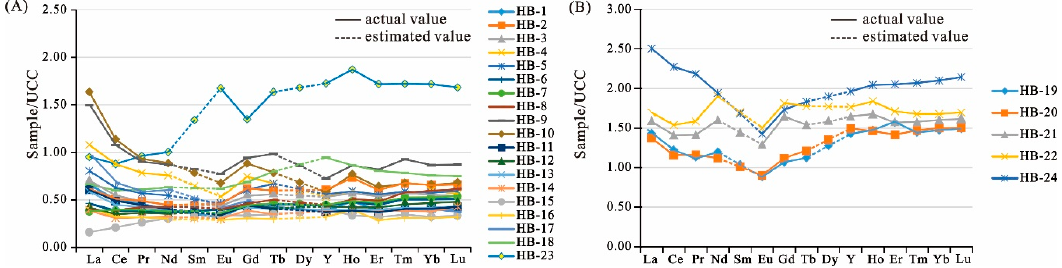
Figure 6. Distribution patterns of REY of the Hebi No. 6 mine samples. ( A ) Distribution pattern of REY in No. 2 1 coal; ( B ) distribution pattern of REY in the partings and floor samples. Note that because the test values of Sm and Dy are abnormal, in this paper they are corrected by interpolation. The numerical value of the dotted line in the REE distribution pattern is the interpolation of the ratio of the REE content on the adjacent sides to the average upper crust content. The calculation formula is as